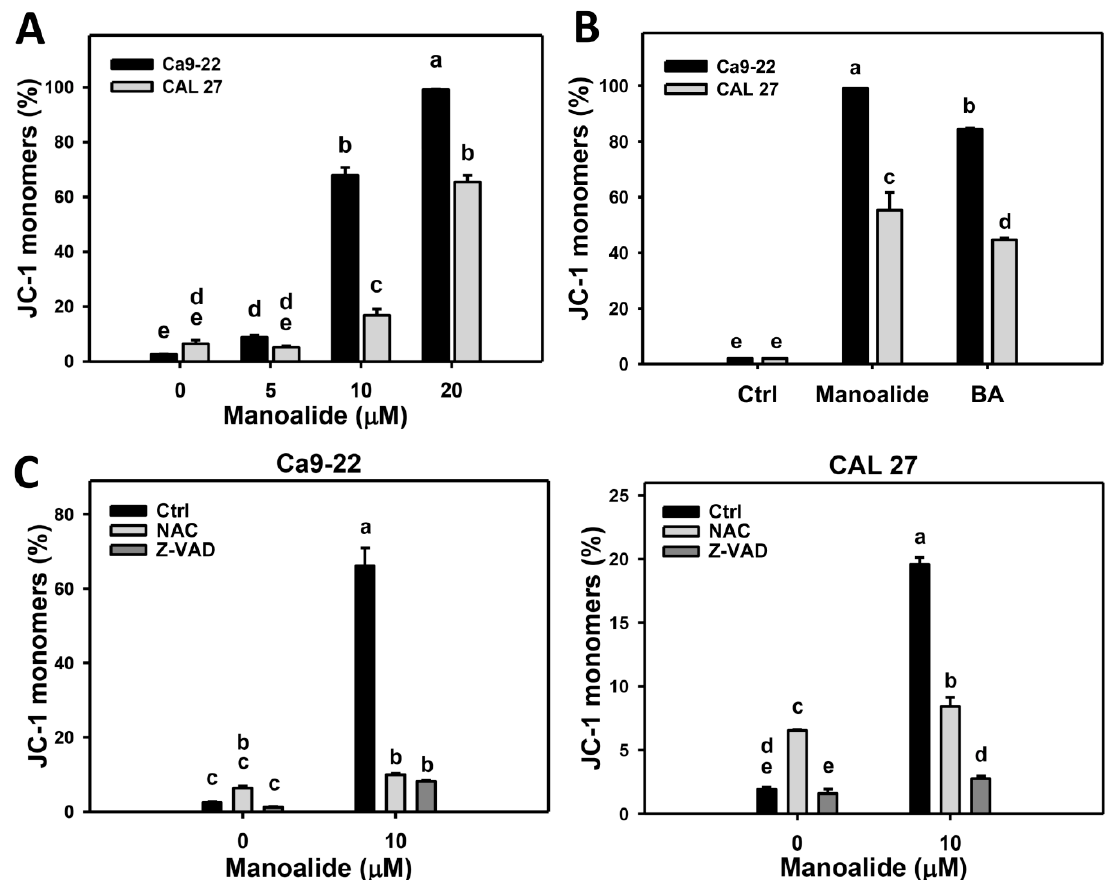
Figure 6. Change of membrane potential (MitoMP) in manoalide-treated oral cancer (Ca9-22 and CAL 27) cells. ( A ) Statistical results of JC-1 monomers (%) for manoalide-treated oral cancer cells in Figure S9A. Cells were treated with di ff erent concentrations of manoalide for 24 h. High JC-1 monomers (%) indicates low MitoMP, i.e., the MitoMP depolarization. ( B ) Statistical results of positive control of low MitoMP for oral cancer cells in Figure S9B. Cells were treated with betulinic acid (BA; 25 µ M, 24 h) as the positive control treatment for comparison to manoalide (10 µ M, 24 h). ( C ) Statistical results of JC-1 monomers (%) for NAC, Z-VAD, and / or manoalide-treated oral cells in Figure S9C. Cells were pretreated with NAC (8 mM, 1 h) or Z-VAD (100 µ M, 2 h) and posttreated with manoalide (10 µ M, 24 h). Data, means ± SDs ( n = 3). Data were analyzed by one-way ANOVA with Tukey HSD Post Hoc Test. Data showing no overlapping same small letters represent significant di ff erence ( p < 0.05–0.001).